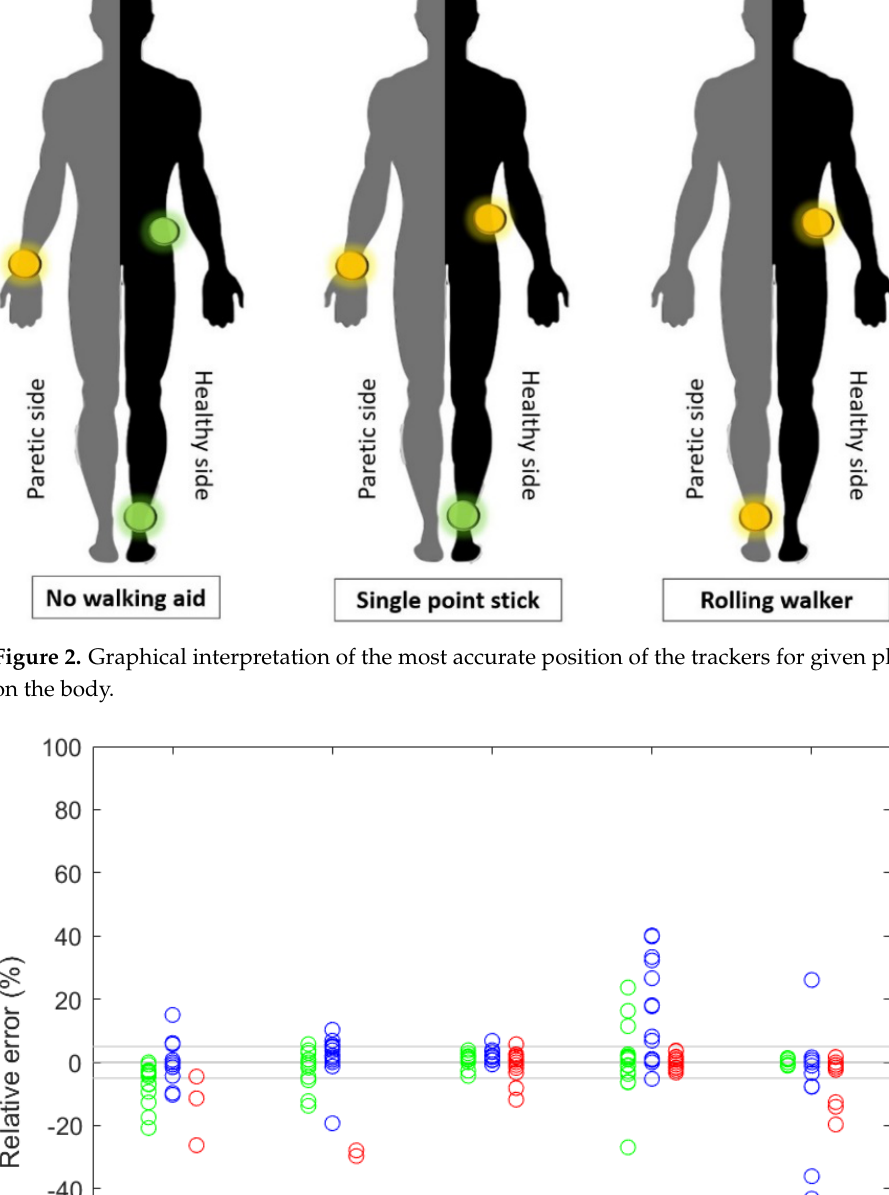
Figure 2. Graphical interpretation of the most accurate position of the trackers for given placement on the body.